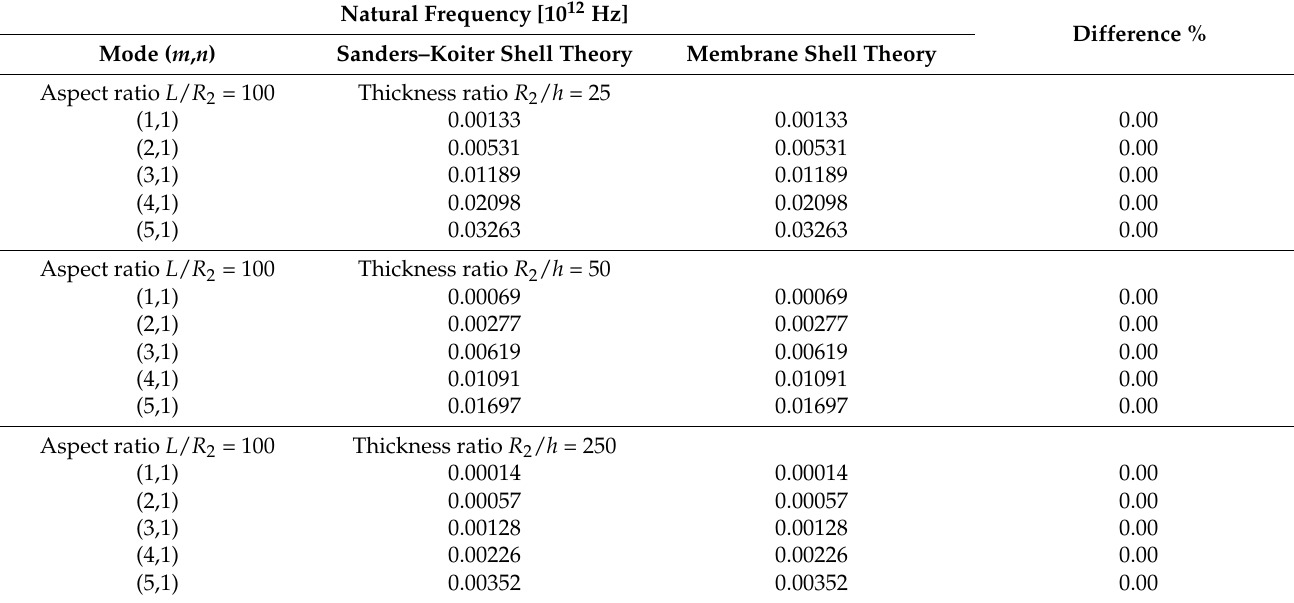
Table 11. Simply supported DWCNT with aspect ratio L / R 2 = 100 and thickness ratios R 2 / h = (25,50,250). Beam-like modes ( n = 1). Comparisons between Sanders–Koiter and membrane shell